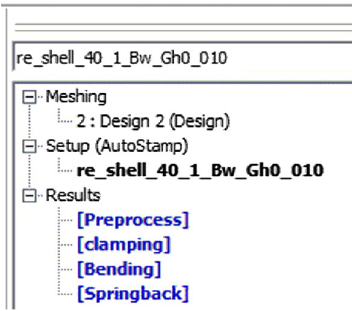
Fig. 6 Arrangement of tools and spring elements in FE simulations